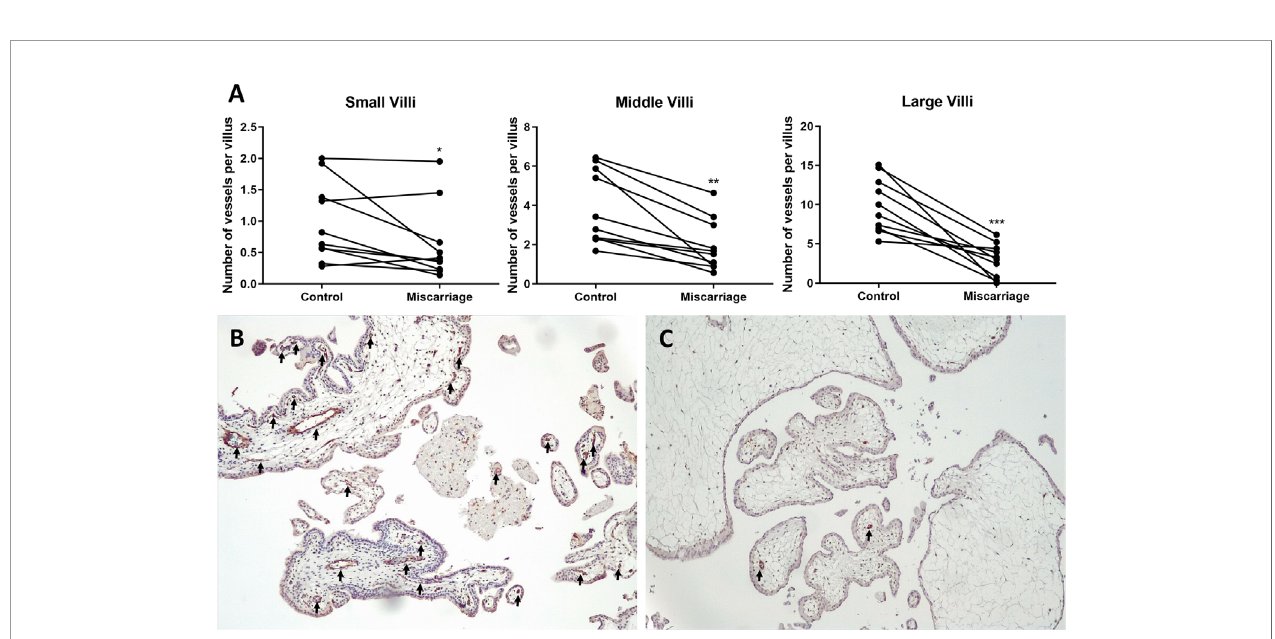
FIGURE 7 | Immunohistochemical staining of CD31 in gestation age-paired placenta tissues (n = 10 each group). (A) Paired t-test (for Middle and Large Villi) and Wilcoxon matched-pairs signed rank test (for Small Villi) of vessels ’ numbers in different size groups of villi. (B) Placenta of Normal Control group (8 + 2 weeks, 100× magni fi cation). (C) Placenta of Miscarriage group (8 + 3 weeks, 100× magni fi cation). Black arrows: vessels. *P < 0.05, **P < 0.01, ***P <